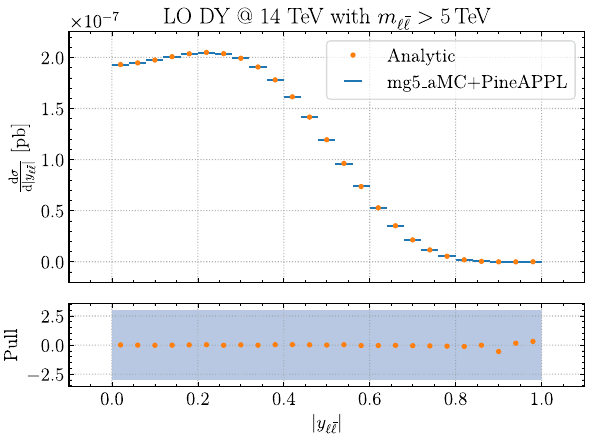
Fig. 4 Same as Fig. 3 but now for the absolute dilepton rapidity dis- tribution | y (cid:2) ¯ (cid:2)